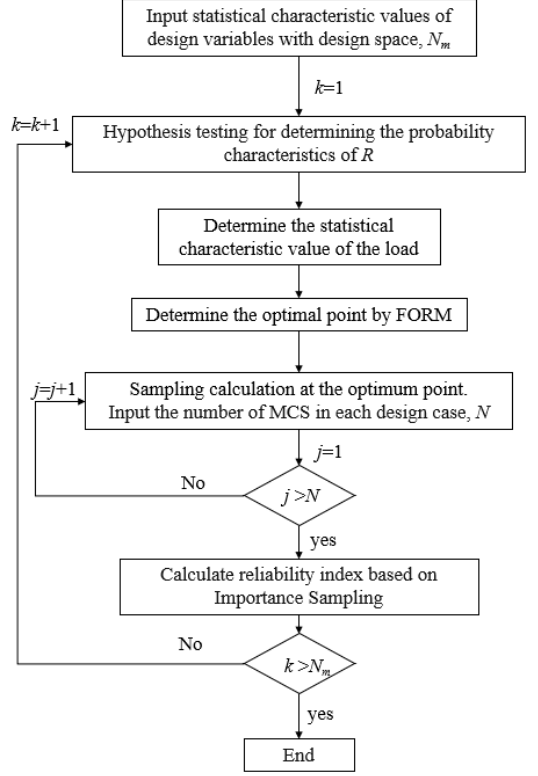
Figure 8. Flowchart of the reliability analysis based on IS.